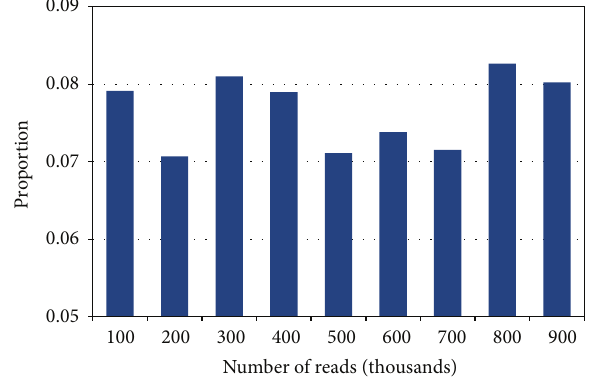
Figure 5: Proportion of ambiguously mapped contigs (before the selection of the best mapping for each contig) in case of various numbers of simulated